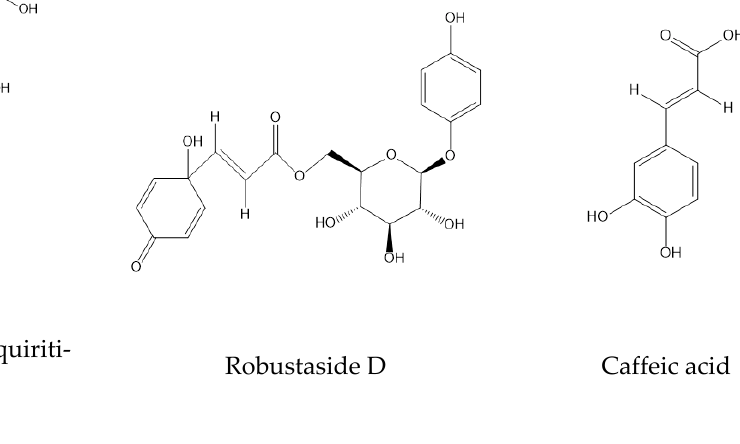
Figure 5. Different classifications of compounds and their relative contents found in EAF from Pingguoli pear fermentation broth. The different colors represented different classifications. Table 5. Identification of ten main compounds in the EAF from Pingguoli pear fermentation broth by HPLC-MS/MS.